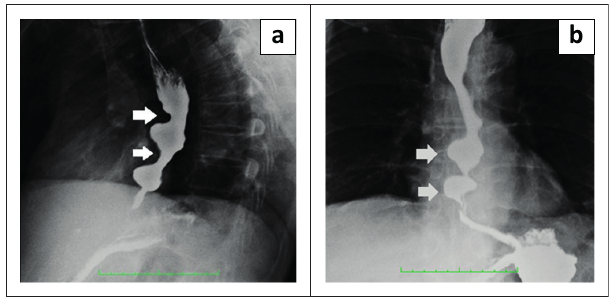
FIGURE 2: (a) Barium swallow Left anterior oblique (LAO) view – Arrows denote the areas of narrowing in the lower thoracic oesophagus. (b) Barium swallow Antero – posterior (AP) view – Arrows denote the areas of dilatation of the oesophagus proximal to the areas of narrowing.